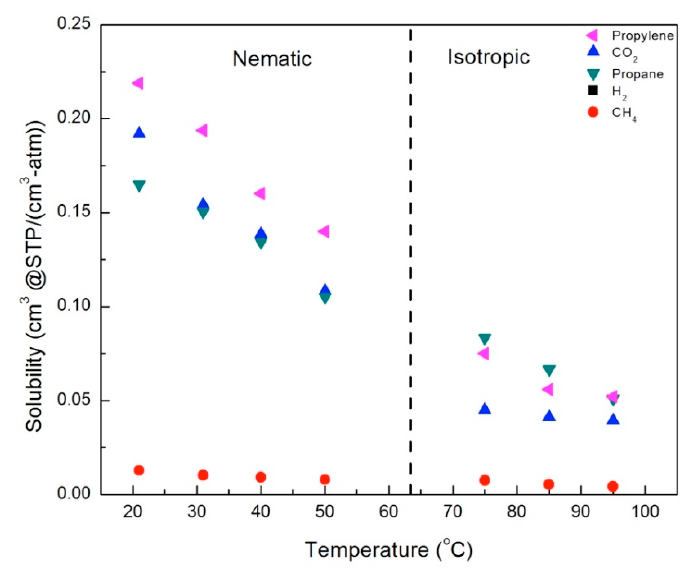
Figure 14. Solubilities for gases in the CNBPh75_5.0 membrane (5.0% crosslinker) in the nematic and isotropic phases.